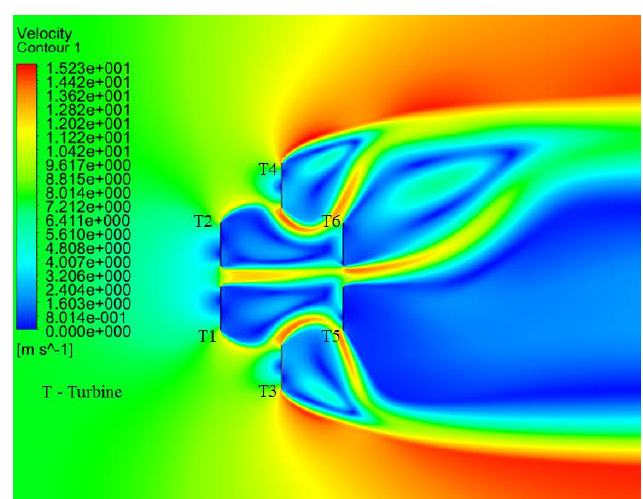
Figure 11. Velocity contours for the hexagon platform.